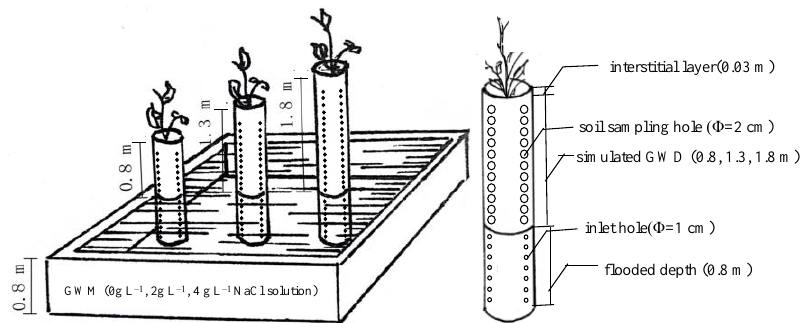
Figure 1. The simulated setup for the soil columns planted with R. pseudoacacia.